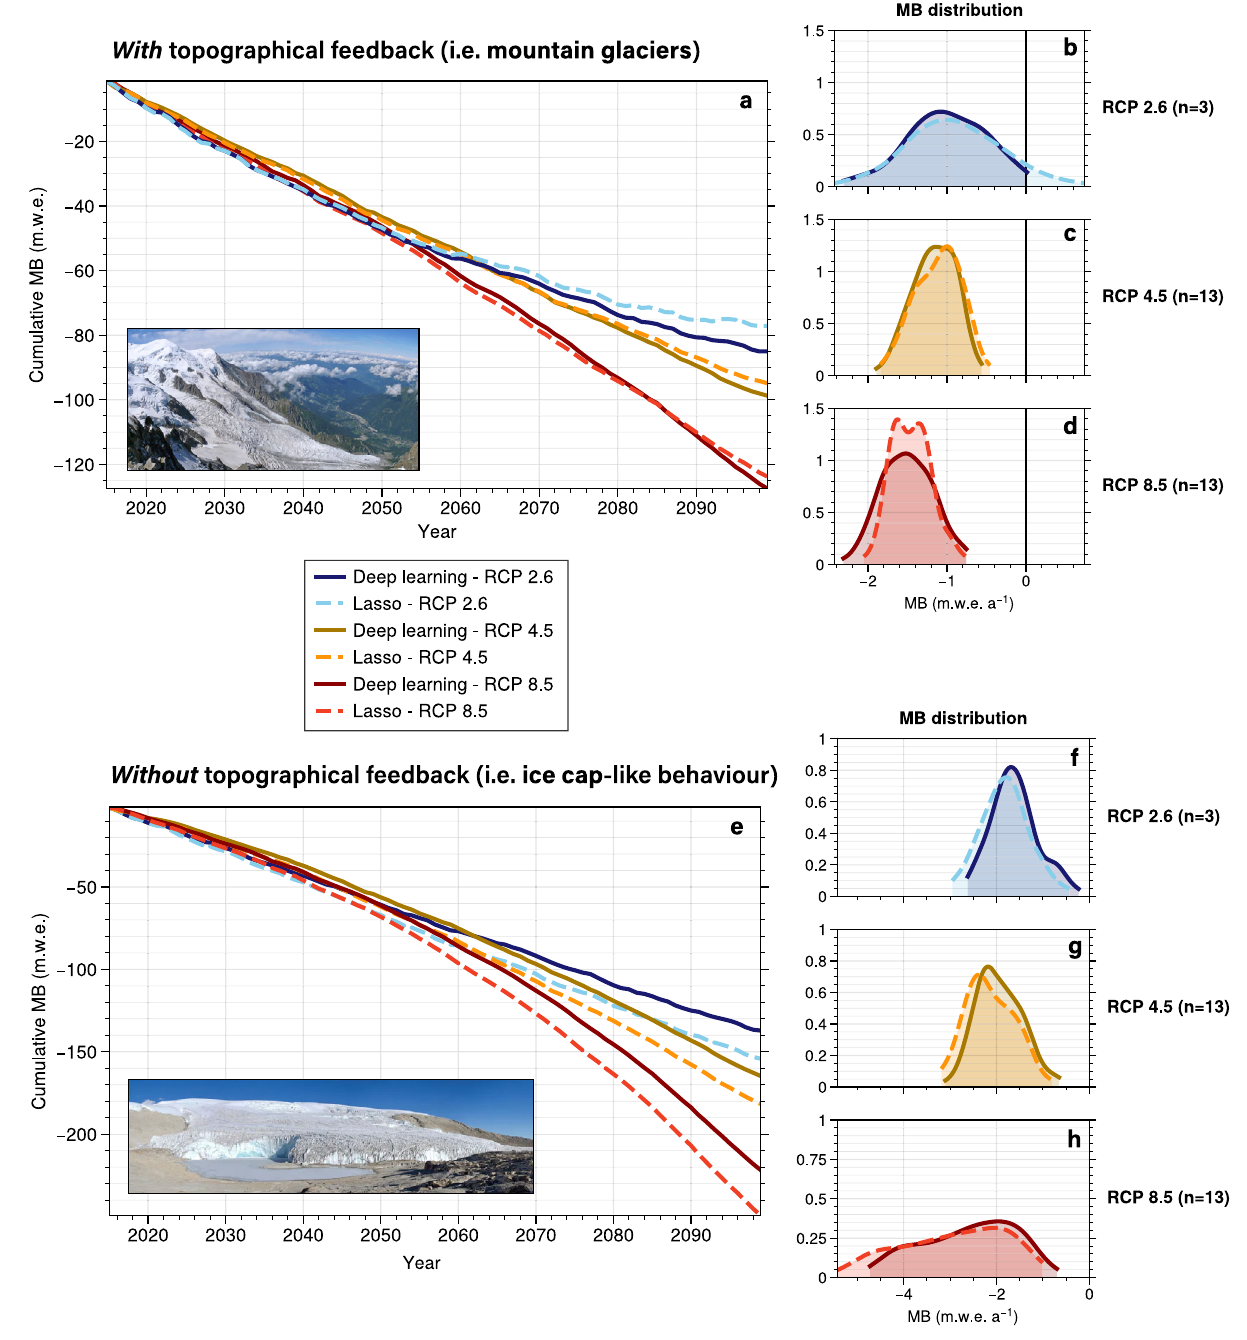
Fig. 4 Effect of deep learning nonlinearities on glacier mass balance projections. Average cumulative MB projections of French Alpine glaciers with a nonlinear deep learning vs . a linear Lasso model for 29 climate scenarios; a with topographical feedback (allowing for glacier retreat) and e without topographical feedback (synthetic experiment with constant mean glacier altitude). The projections without glacier geometry adjustment explore the behaviour of glaciers which cannot retreat to higher elevations (i.e. ice cap-like behaviour). b , c , d and f , g , h annual glacier-wide MB probability distribution functions for all n scenarios in each RCP. Vertical axes are different for the two analyses. Photographs taken by Simo Räsänen (Bossons glacier, European Alps, CC BY-SA 3.0) and Doug Hardy (Quelccaya ice cap, Andes, CC BY-SA